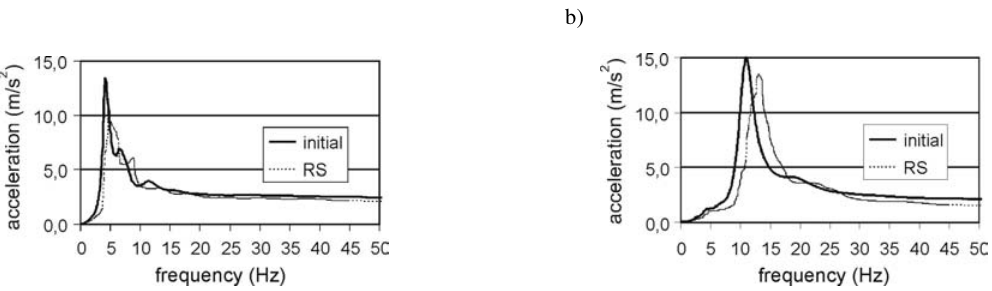
Fig. 14. In-structure acceleration response spectra in selected point at refuelling machine level: a – horizontal